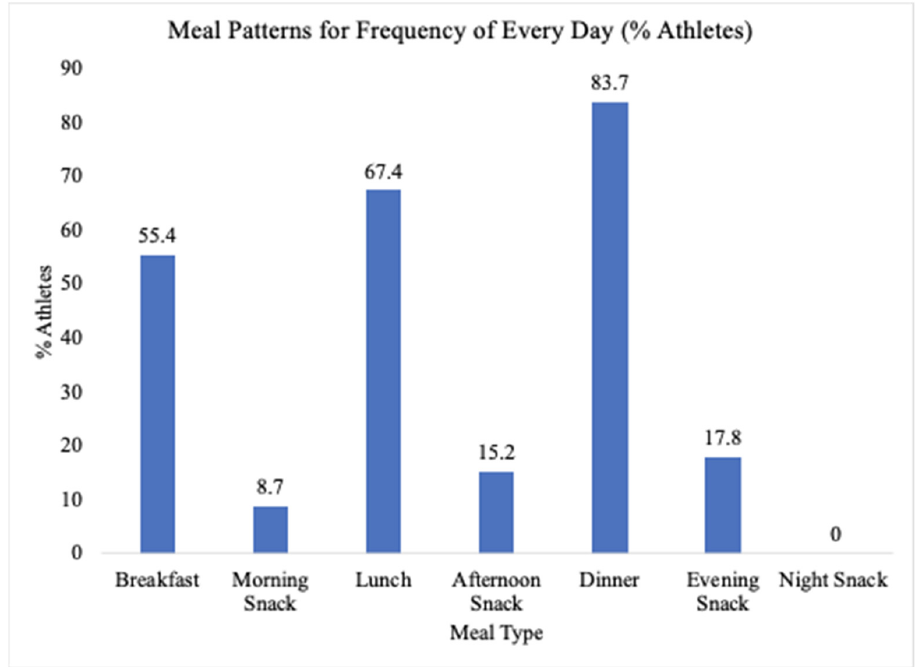
Figure 2. Meal pattern questionnaire results.